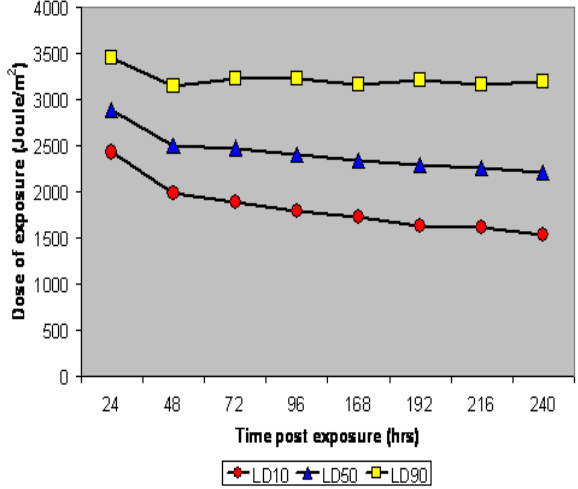
Figure 2: Top curves for UV-B in Bufo arenarum embryos